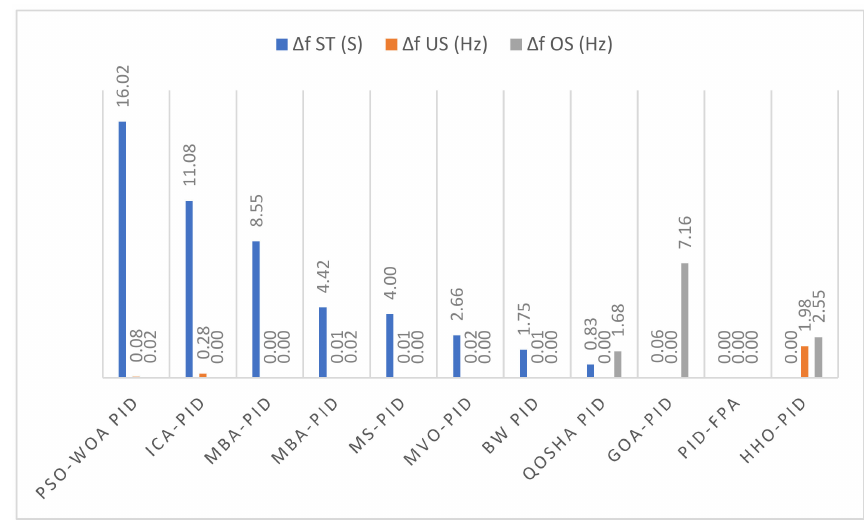
Figure 9. Frequency Deviation for Isolated